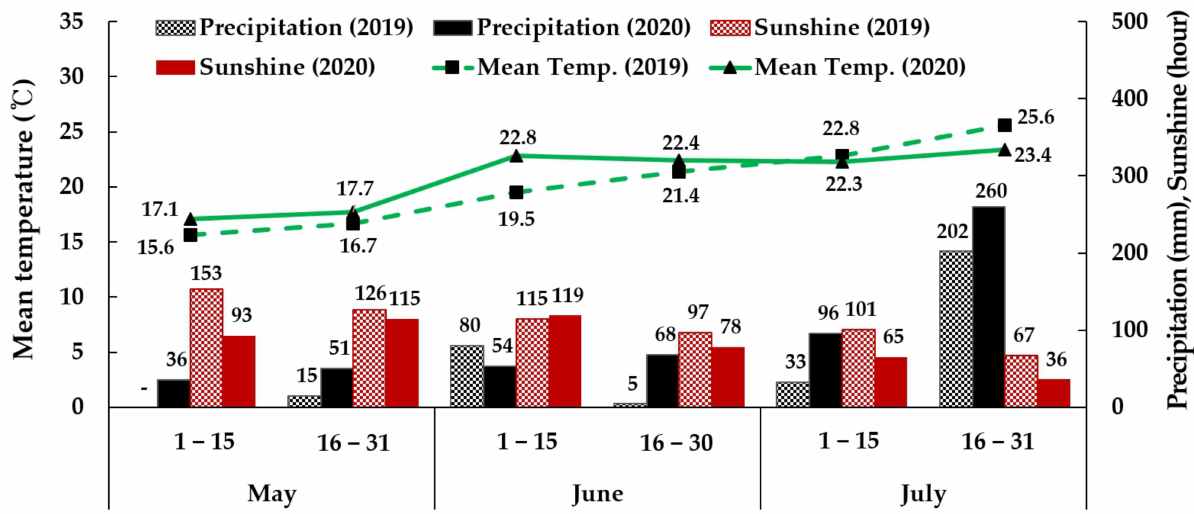
Figure 1. Meteorological data during the rice-growing period. Data of the mean temperature, precipitation, and sunshine hours were obtained from the website of the Korean Meteorological Administration